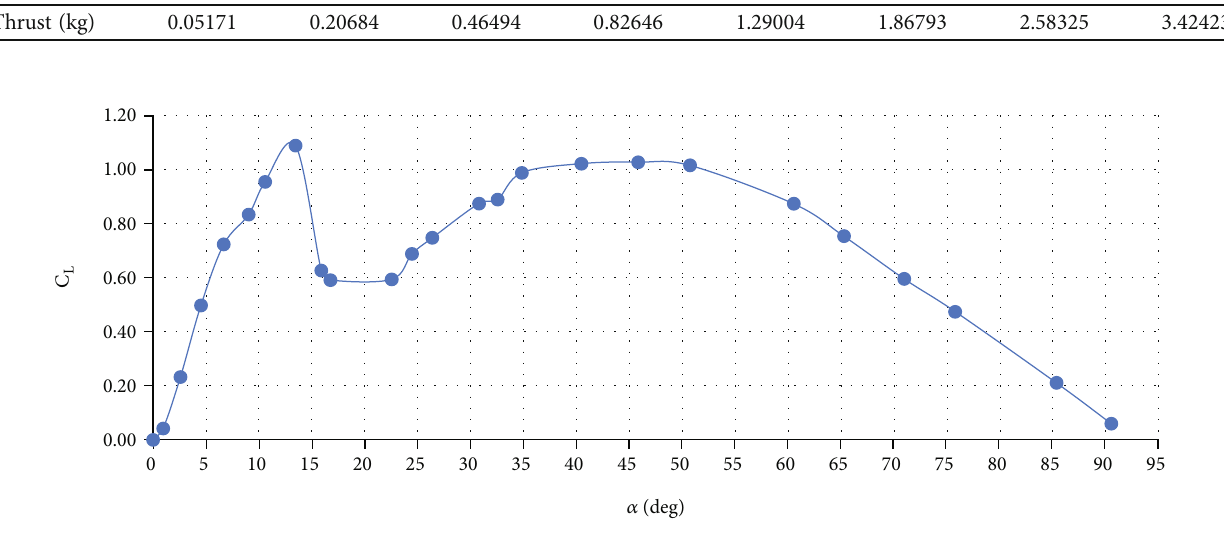
α at Re = 3 : 6 ∗ 10 5